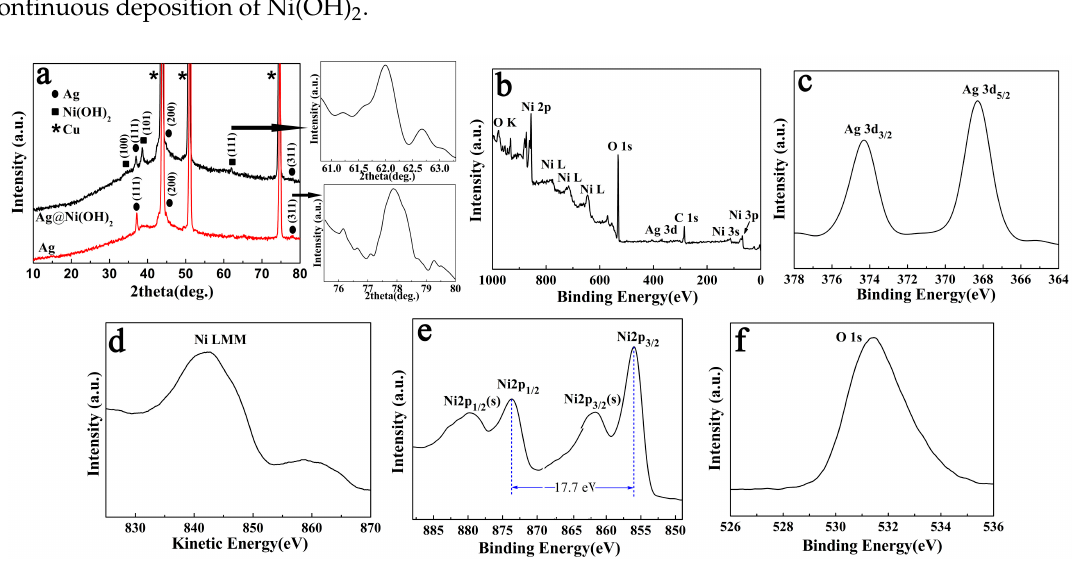
Figure 4. ( a ) XRD patterns of Ag and Ag@Ni(OH) 2 (The arrows point to a higher magnification); ( b–f ) XPS spectra of the Ag@Ni(OH) 2 : survey scan, Ag 3d, Ni LMM, Ni 2p and O 1s.